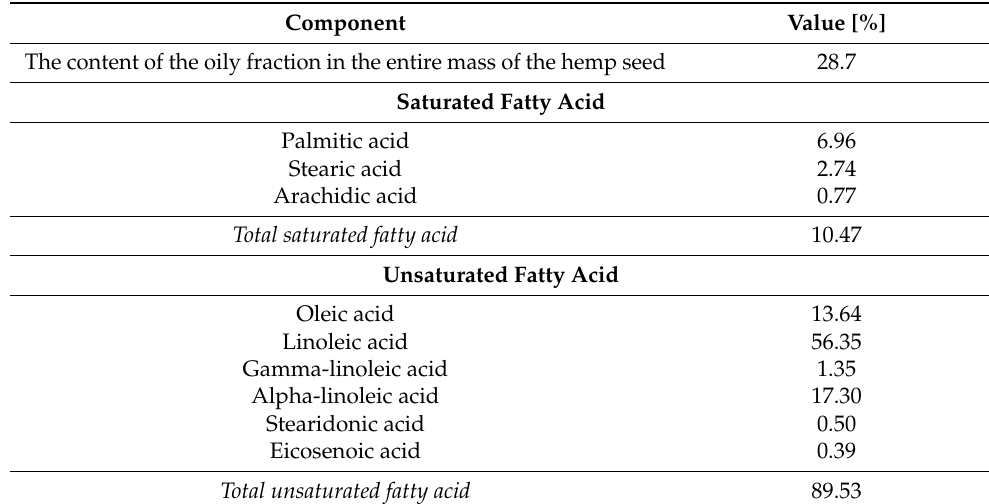
Table 2. Composition of the oily fraction derived from hemp seeds. Component The content of the oily fraction in the entire mass of the hemp seed